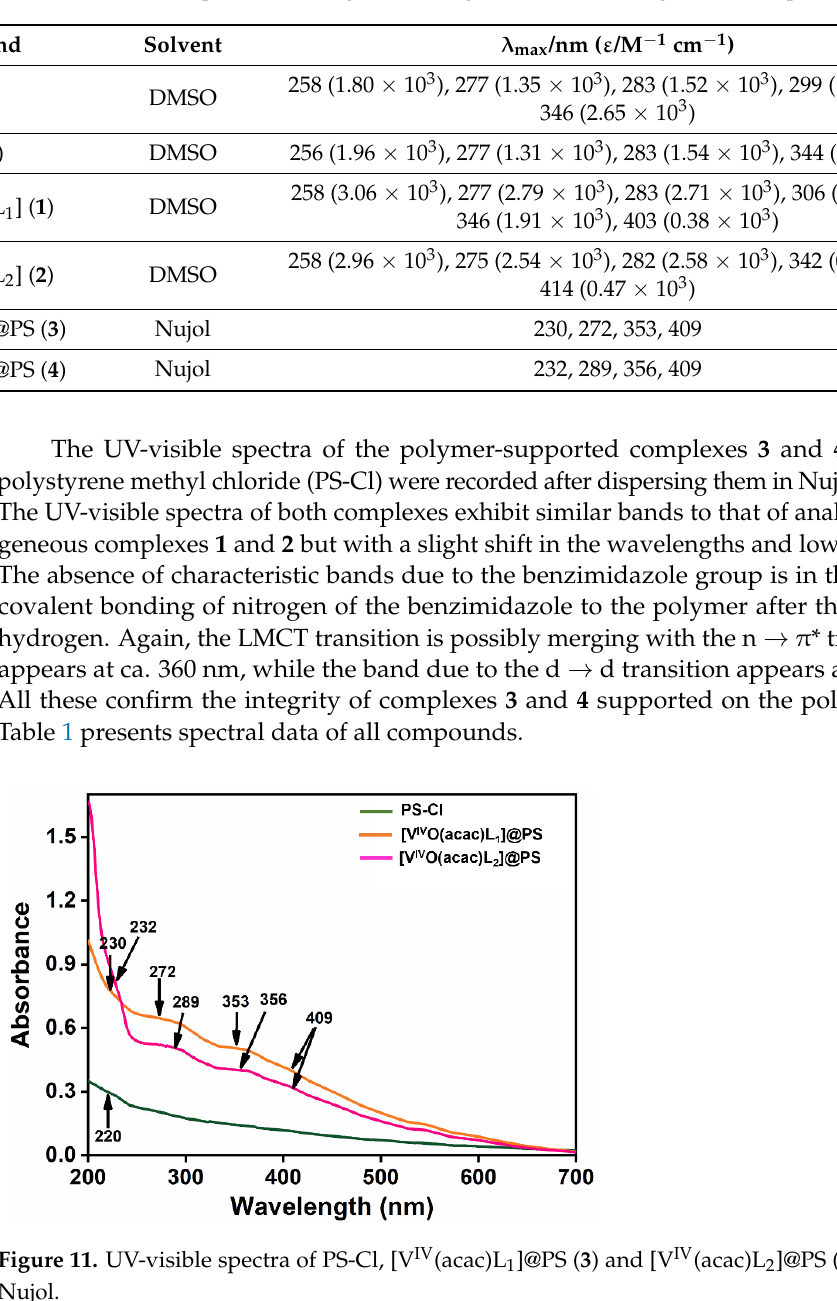
Table 1. UV-visible spectra of the ligand, homogeneous and heterogeneous complexes.